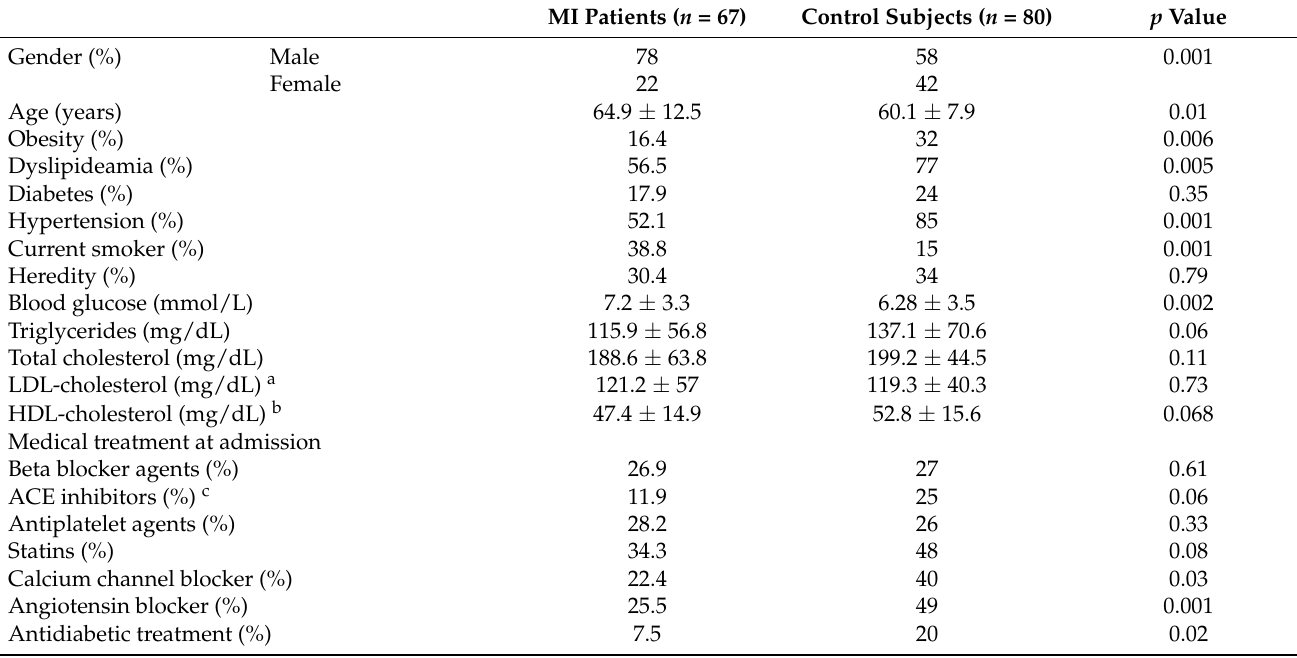
Table 1. Baseline characteristics of MI patients and control